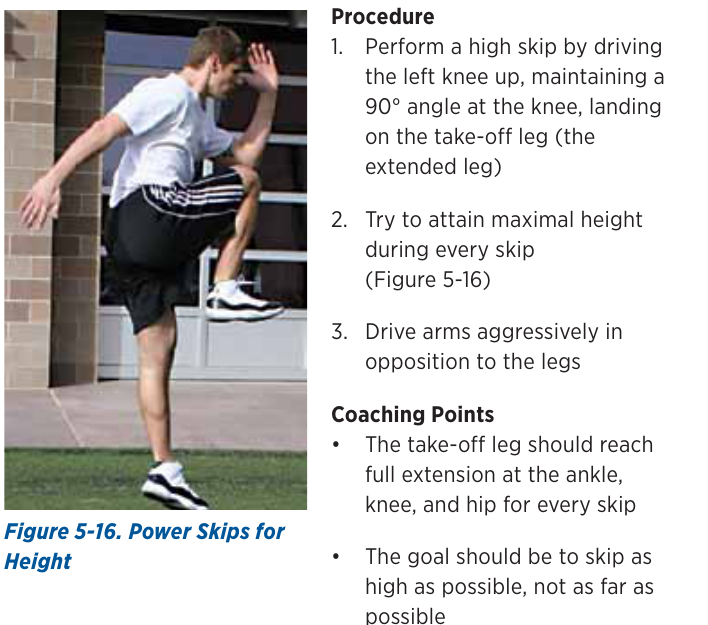
Figure 5-16. Power Skips for